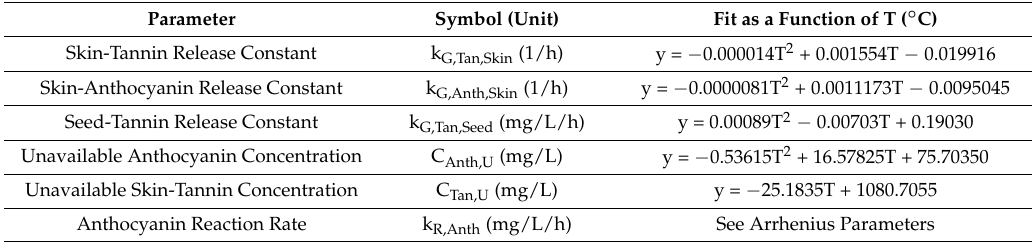
Table 2. Arbitrary regression functions used to describe the temperature dependence of each